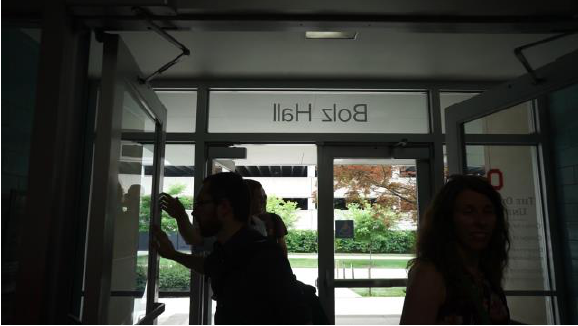
Figure 7. View from Sony_2 while passing through a building